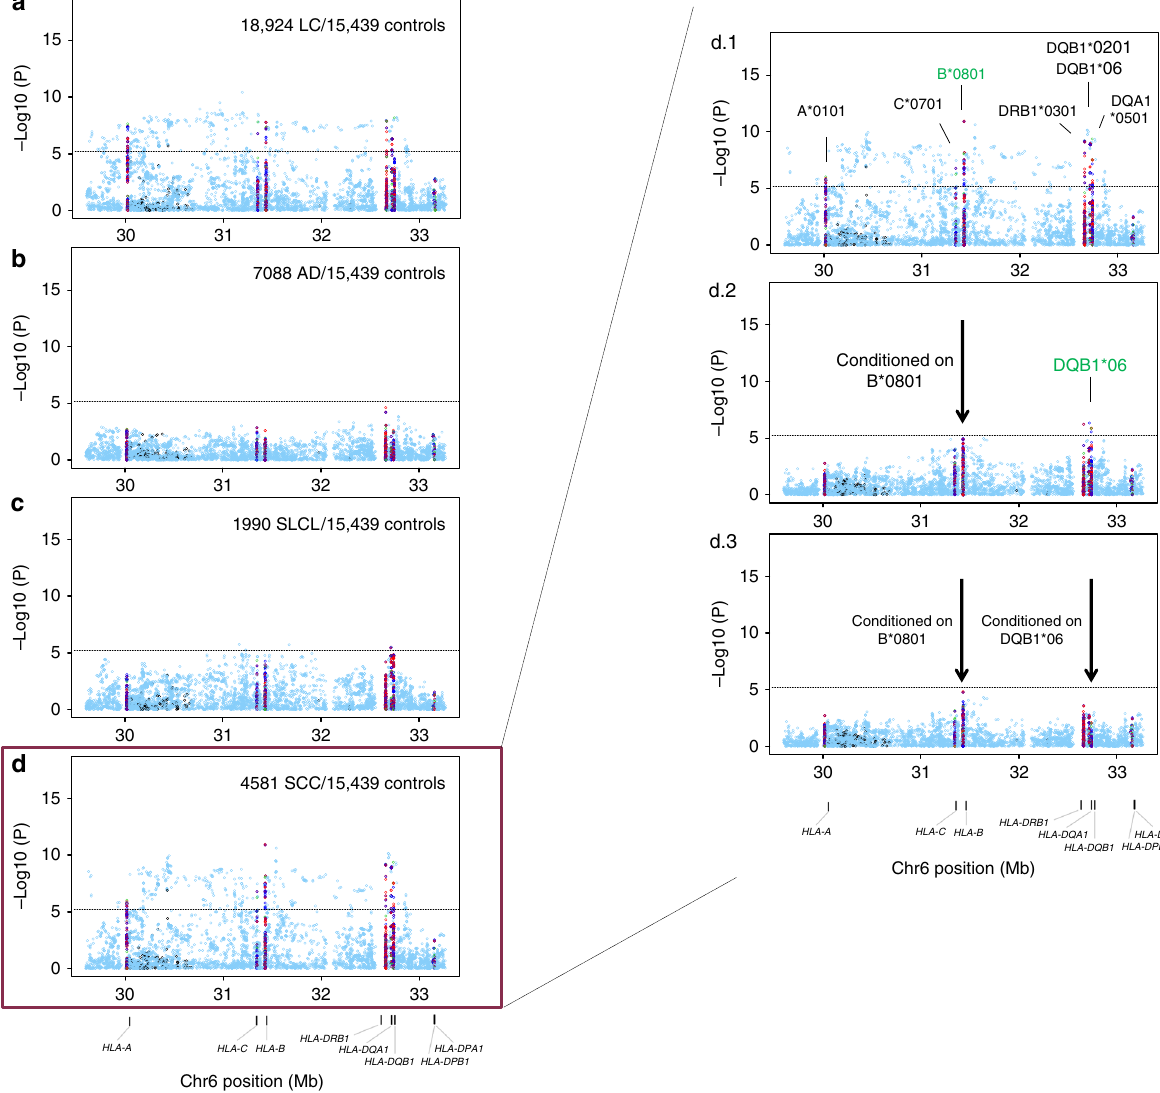
Fig. 1 European regional association plots of variants in the MHC region and lung cancer overall and major histologies ( a – d ); plots of stepwise conditional analyses for squamous cell carcinoma (d.1 – d.3). Each panel on the left shows the association plot for each unconditioned analysis a lung cancer overall, b adenocarcinoma, c small cell, d squamous cell carcinoma. The association for each locus used for conditioning is shown in green in each panel (d.1) unconditioned, (d.2) conditioned on HLA-B*0801 , (d.3) conditioned on HLA-B*0801 and HLA-DQB1*06 . Detailed association results in Table 2 and Supplementary Fig. 1. Circles represent – log10 ( P values) for each binary marker using the imputed allelic dosage (between 0 and 2). The dashed black horizontal lines represent the study-wide signi fi cant threshold of P = 6 × 10 − 6 . The physical positions of HLA genes on chromosome 6 are shown at the bottom. The color of the circles indicates the type of marker; light blue — SNPs outside HLA genes, green — classical HLA alleles and red — amino acid polymorphisms of the HLA genes; deep blue — SNP within HLA